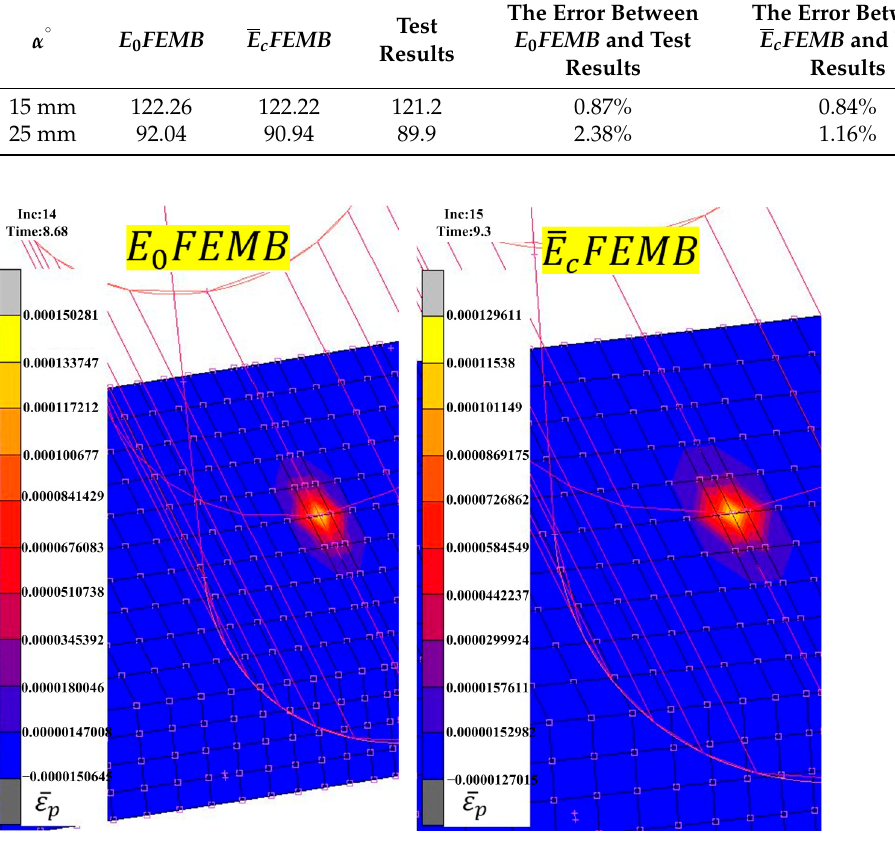
Figure 13. Comparison of equivalent plastic strain at the beginning of the plastic stage. Table 5. Comparison of springback results in three-point bending.